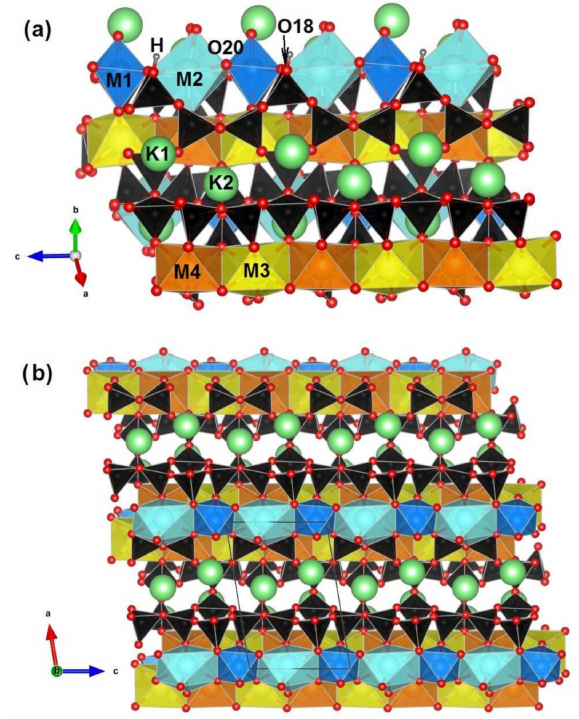
Figure 1. Crystal structure of the studied tinaksite projected down to {110} ( a ) and {010} ( b ). Si- tetrahedra are black; Ti-octahedra (M1) and Na-polyhedra (M2) are blue and cyan, respectively; M3 and M4 Ca-octahedra are yellow and orange, respectively. In the tokkoite crystal structure, all the M positions are occupied by Ca ions. K atoms are light green, O and H atoms are drawn in red and grey, respectively. The figure was prepared in the program VESTA (version 4.3.0) [20] using single-crystal data obtained in